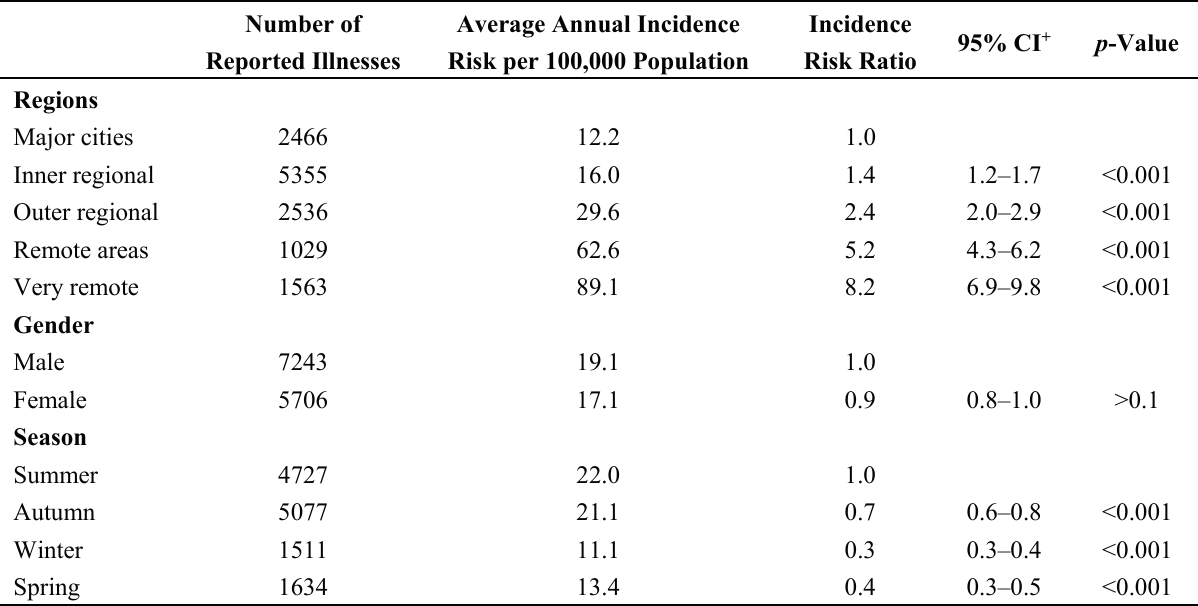
Table 1. Negative binomial regression model results of incidence risk of cryptosporidiosis reported in Australian children <5 years across an urban-rural gradient, controlling for season, population size and gender, 2001–2012. Number of Average Annual Incidence Incidence 95% CI + p -Value Reported Illnesses Risk per 100,000 Population Risk Ratio 12.2